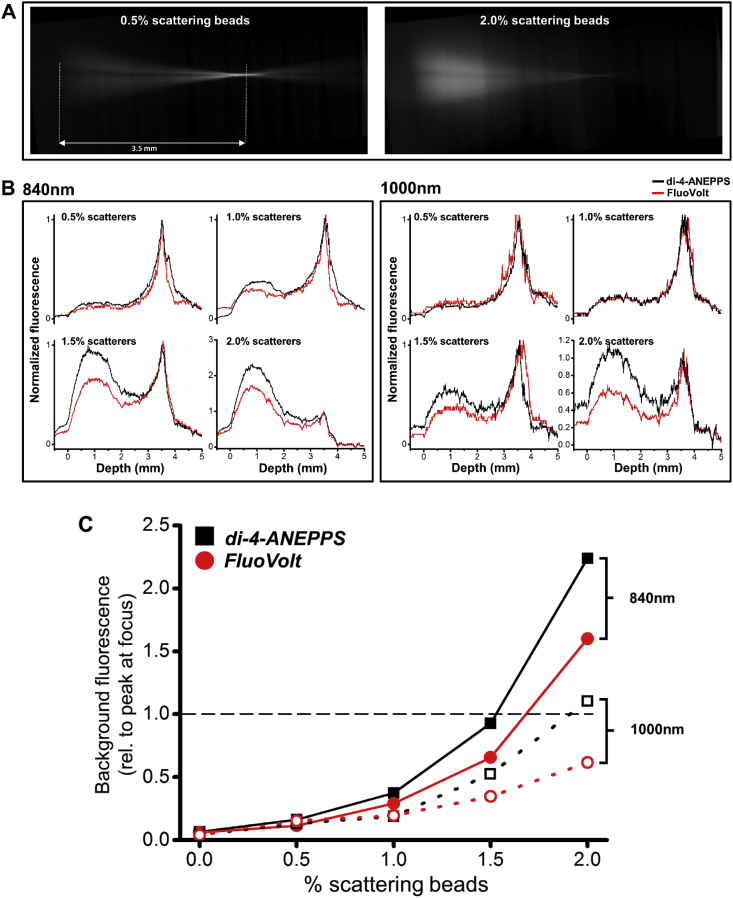
Z-axis two photon axial beam profile. (A) Example images of two photon axial beam profile in fluorescent solution containing 0.5% (left) and 2.0% (right) scattering beads. (B) FluoVolt and di-4-ANEPPS axial beam profiles at 840 nm (left box) and 1000 nm (right box) excitation wavelength, using increasing concentrations of scattering beads. (C) Out-of-focus (background) fluorescence relative to perifocal fluorescence for di-4-ANEPPS and FluoVolt using 840 nm (solid lines) and 1000 nm (dotted lines) excitation. Dashed black line indicates threshold where background dominates and two photon image contrast is lost.